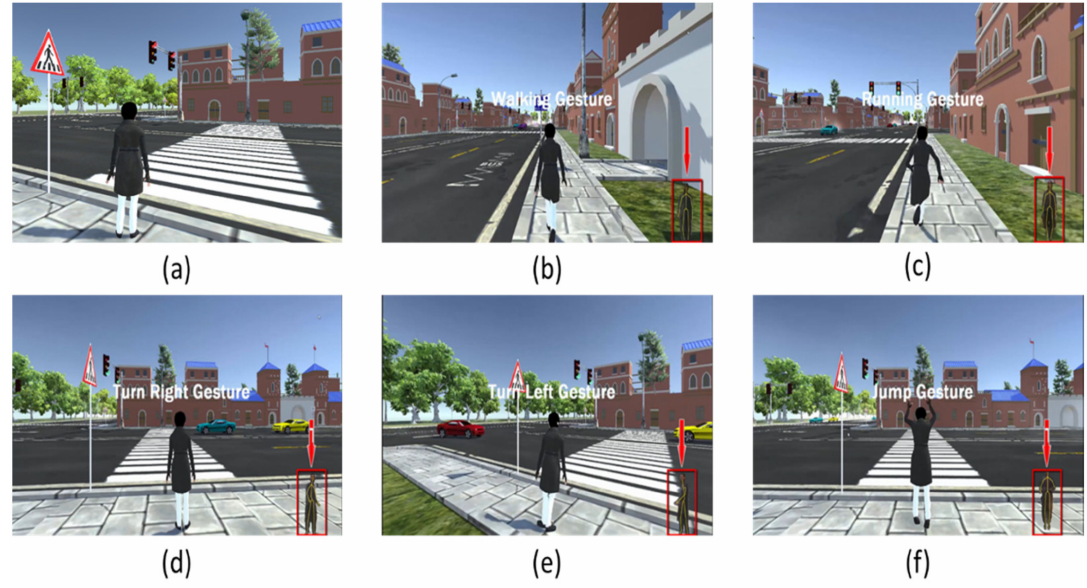
Figure 8. Different gestures of the main avatar: ( a ) idle, ( b ) walking, ( c ) running, ( d ) turning right, ( e ) turning left, and ( f )